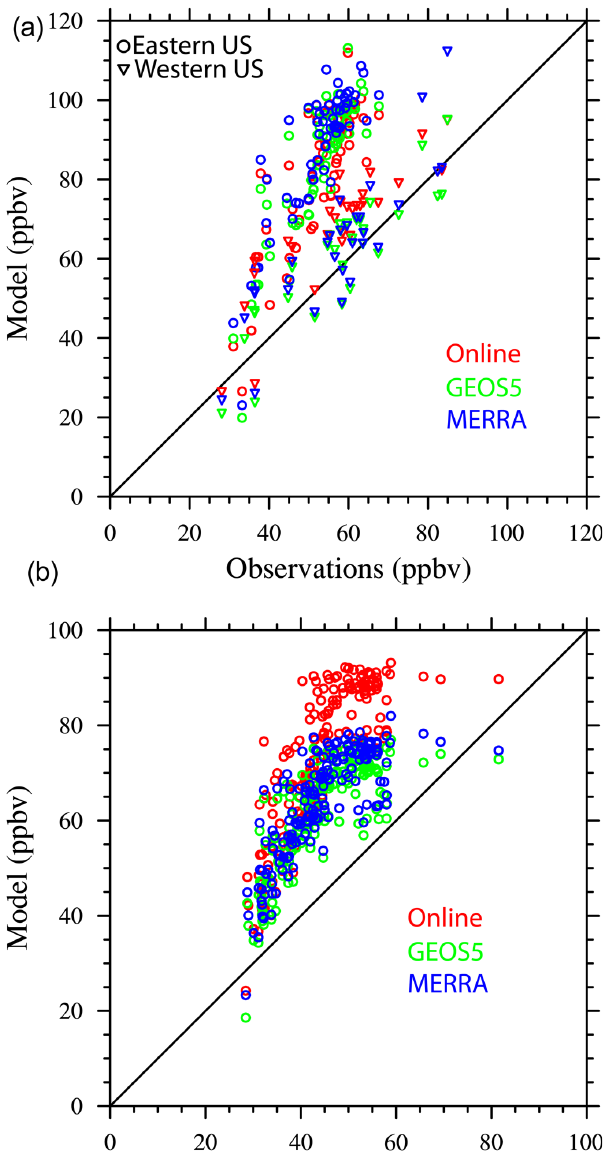
Fig. 8. (a) Comparison of surface ozone summertime 8-h maximum for CASTNET sites over the United States. (b) Same as (a) but for the European EMEP